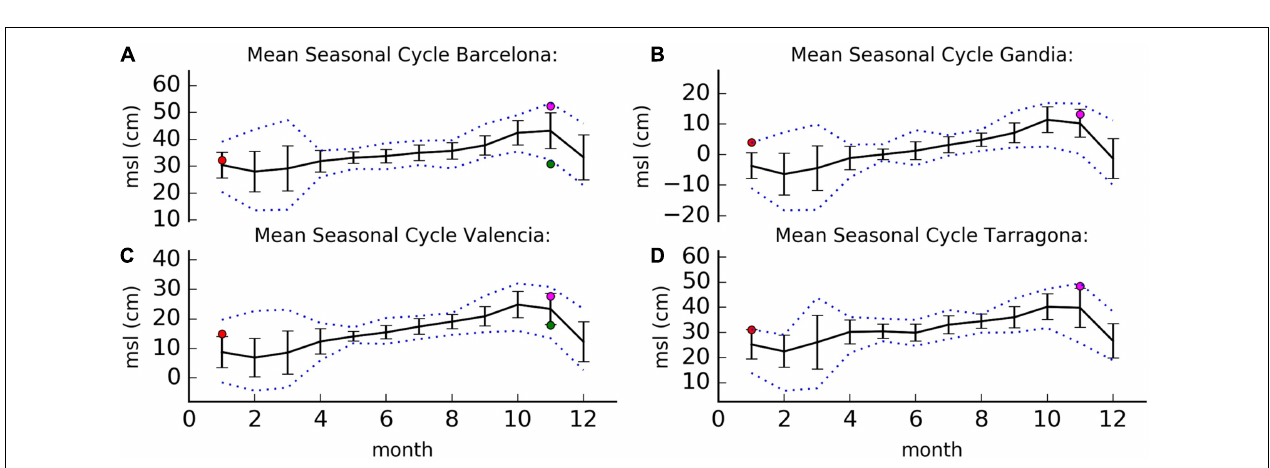
FIGURE 4 | Mean seasonal cycle obtained by averaging monthly MSLs during the whole historical record at Barcelona (A) , Gandía (B) , Valencia (C) , and Tarragona (D) . Black line: averaged monthly means and standard deviation; blue dashed line: maximum and minimum monthly value. Red dot: monthly mean for January 2020 (Gloria). Magenta dot: monthly mean for November 2019. Green dot: monthly mean for November